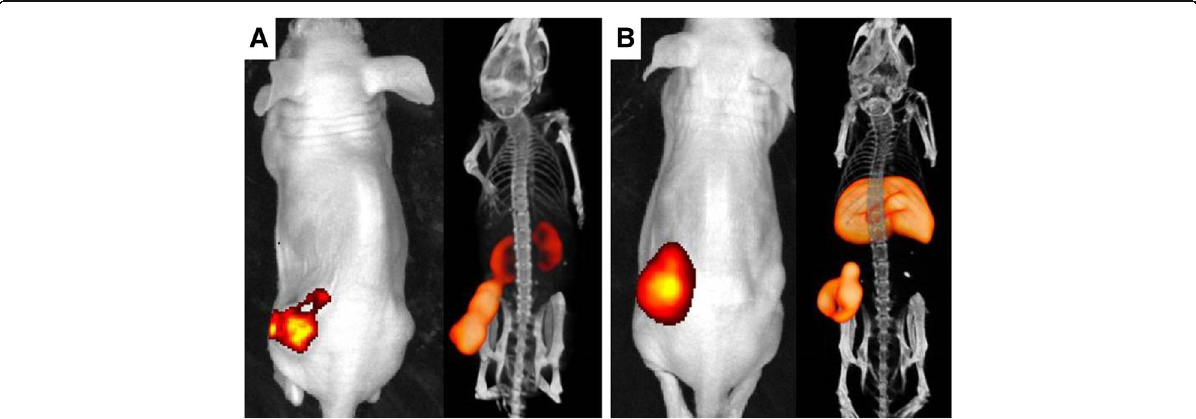
Fig. 2 Near-infrared fluorescence (left) and microSPECT/CT (right) images of mice bearing s.c. CEA-expressing tumors (left flank), acquired using the TF2- 111 In-RDC018 pretargeting strategy ( a ) or the dual-labeled hMN-14 direct targeting strategy ( b ). Both series were acquired 24 h post injection. Note the uptake in the tumor, liver, and kidneys depending on tracer type